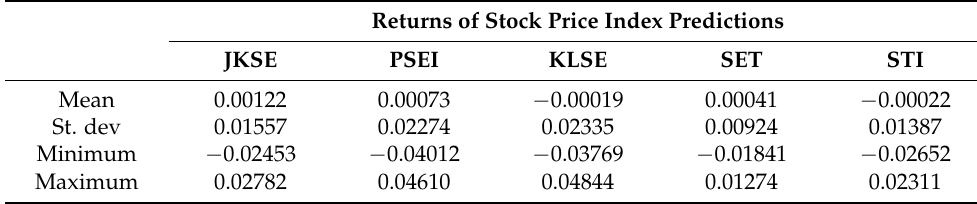
Table 10. Descriptive statistics of stock price index prediction returns for out-sample period.